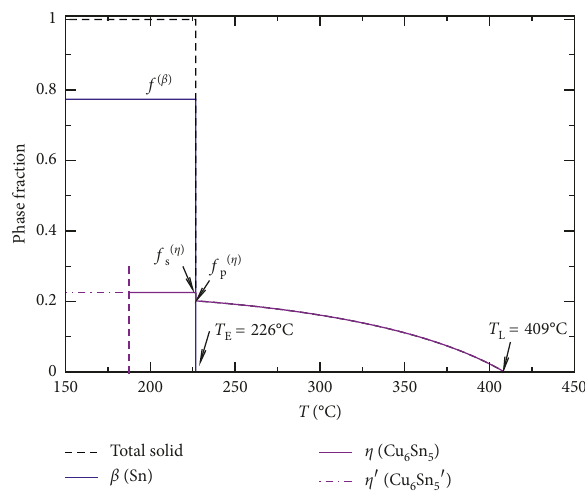
Figure 7: Phase fraction during solidification (calculated under equilibrium